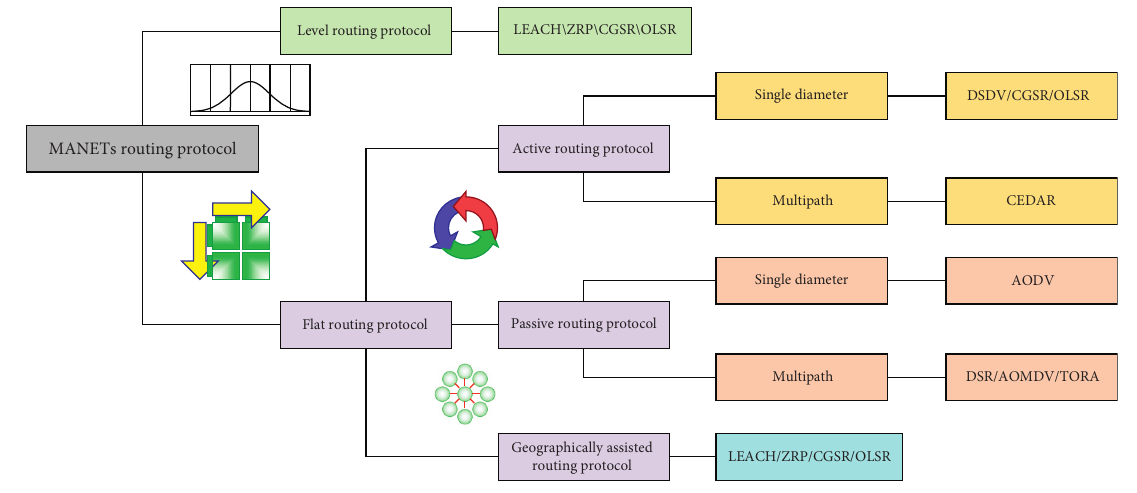
Figure 2: Common MANETs protocols Table 2: The specific simulation